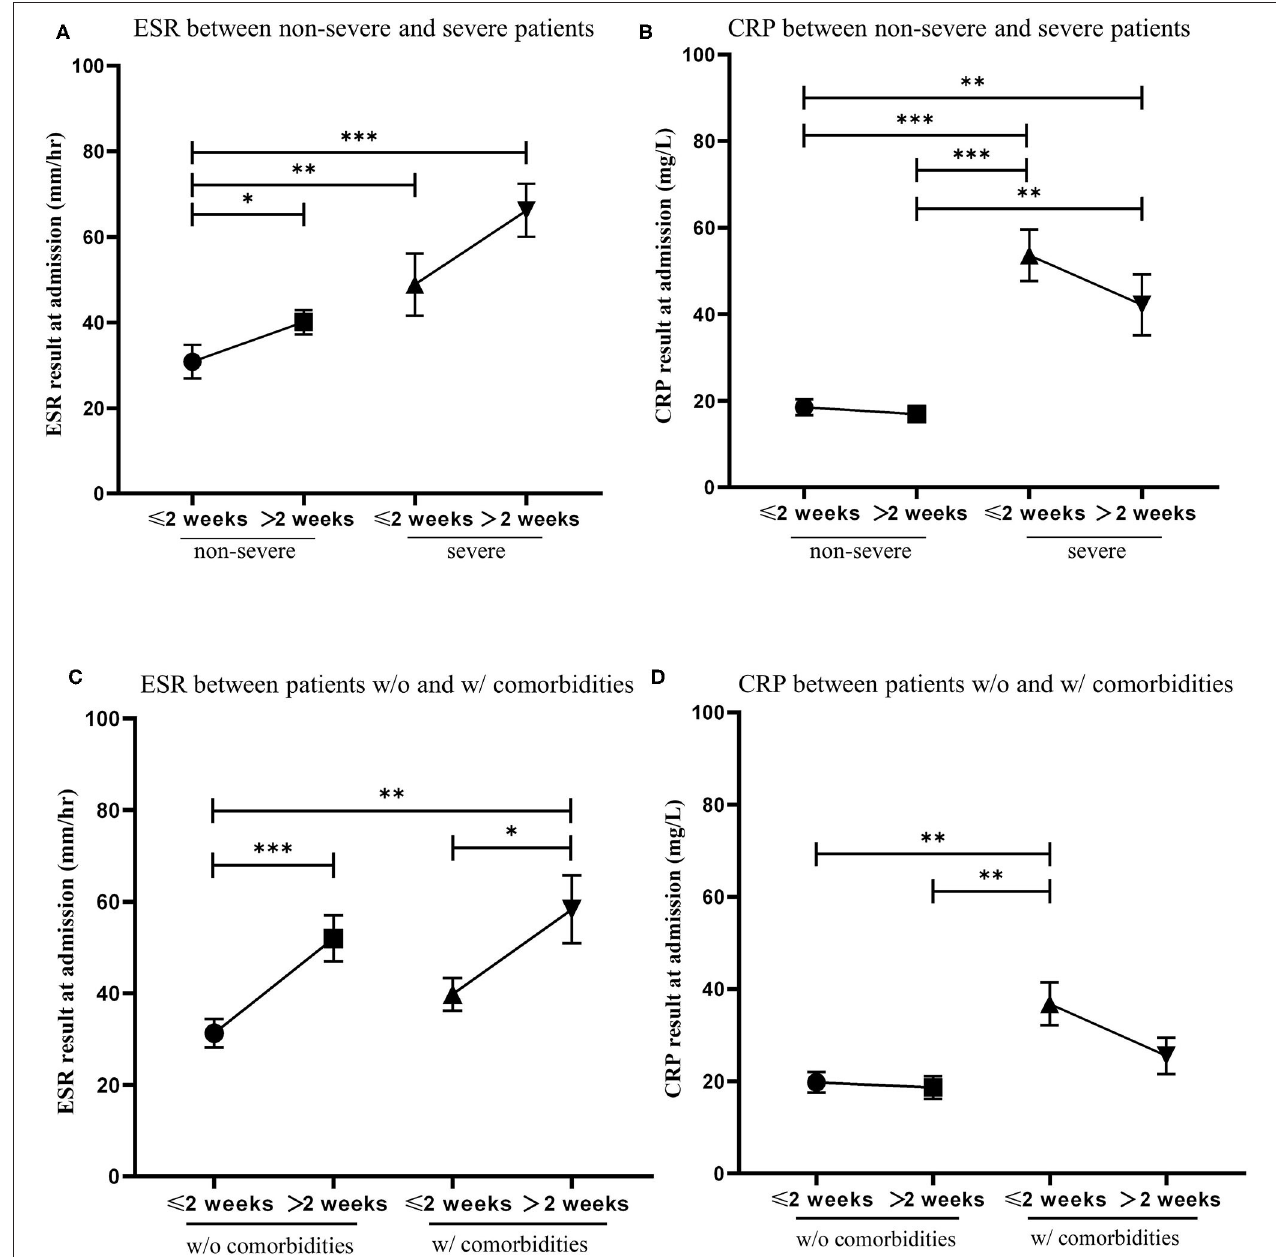
FIGURE 3 | The relationship of the level of erythrocyte sedimentation rate (ESR) and C-reactive protein (CRP) at admission and the conversion time from real-time PCR (rtPCR) positive to negative. (A) Patients were divided into two groups by non-severe and severe cases. Blood test results of ESR was compared between patients recovered from rtPCR positive to negative within 2 weeks and those recovered over 2 weeks. (B) Patients were divided into two groups by non-severe and severe cases. Blood test results of CRP was compared between patients recovered from rtPCR positive to negative within 2 weeks and those recovered over 2 weeks. (C) Patients were divided into two groups by the presence of comorbidities. Blood test results of ESR was compared between patients recovered from rtPCR positive to negative within 2 weeks and those recovered over 2 weeks. (D) Patients were divided into two groups by the presence of comorbidities. Blood test results of CRP was compared between patients recovered from rtPCR positive to negative within 2 weeks and those recovered over 2 weeks. Data are represented the mean ± SEM. The significance was determined as * p < 0.05, ** p < 0.01, and *** p <